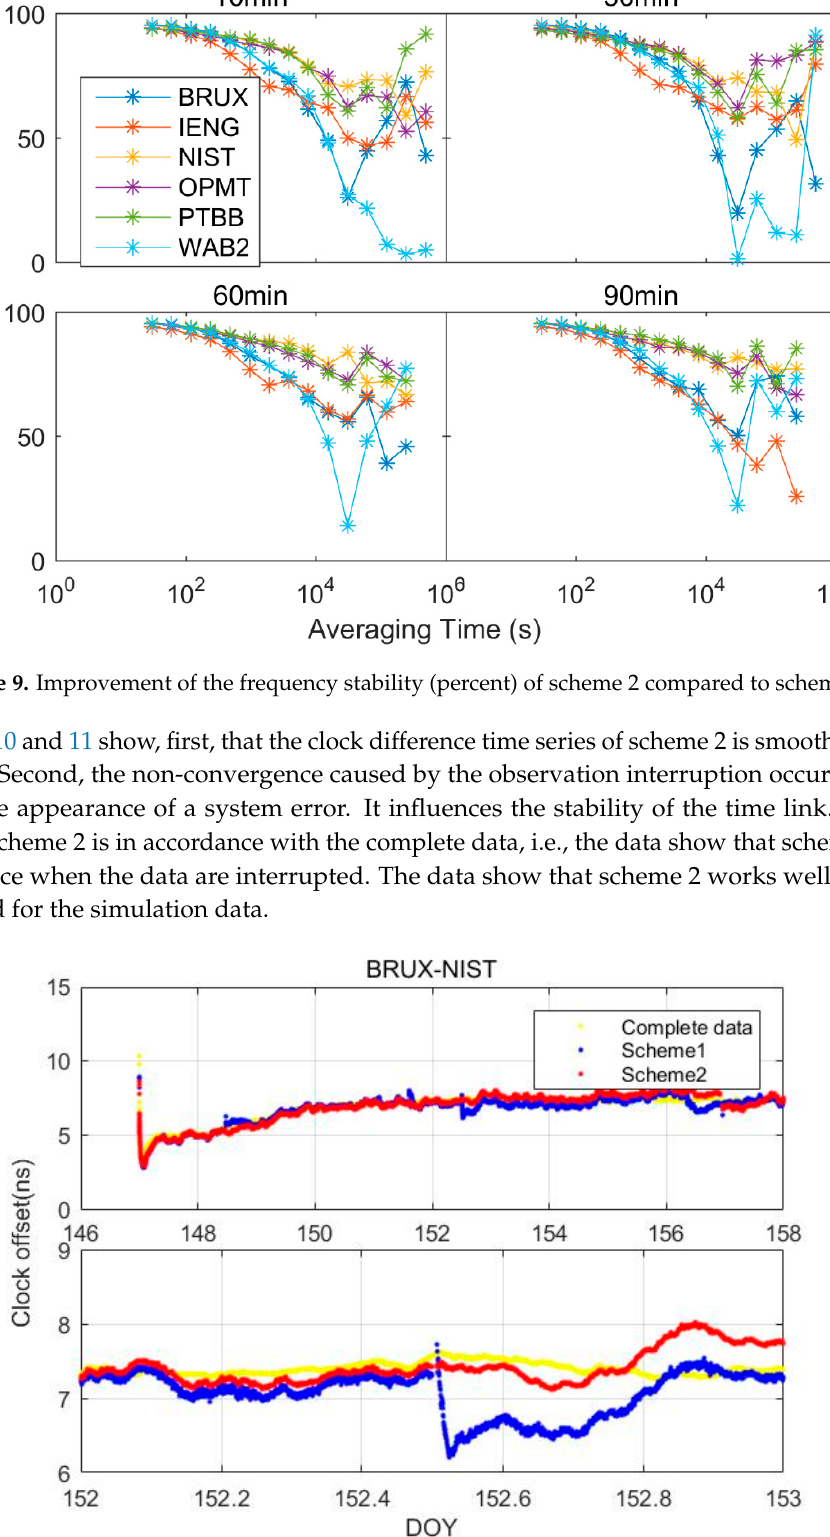
Figure 11. Clock difference time series of scheme 1 ( blue ) and scheme 2 ( red ) with respect to the results of the complete data with the between-epoch constraint model when 10 min of data interruption occurs; the bottom figure is a partial amplification of the top figure. Figure 10 and Figure 11 show, first, that the clock difference time series of scheme 2 is smoother than that of scheme 1. Second, the non-convergence caused by the observation interruption occurs in scheme 1, causing the appearance of a system error. It influences the stability of the time link. Third, the tendency of scheme 2 is in accordance with the complete data, i.e., the data show that scheme 2